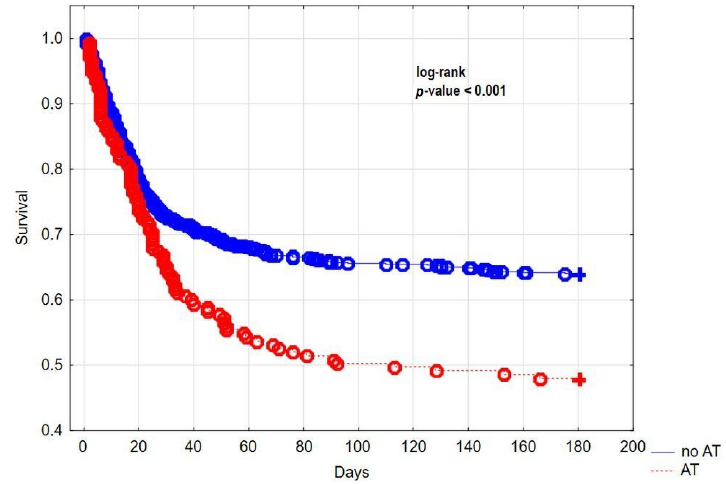
Figure 1. Kaplan–Meier curve showing 180 days survival stratified for patients with and without AT. After PSM, the group of 236 patients receiving AT before hospitalization and 236 pa- tients without previous anticoagulation were selected from the whole study population. The characteristics of two groups of patients (236:236) after PSM are shown in Tables 2 and 3. Table 2. Baseline characteristics in matched patients’